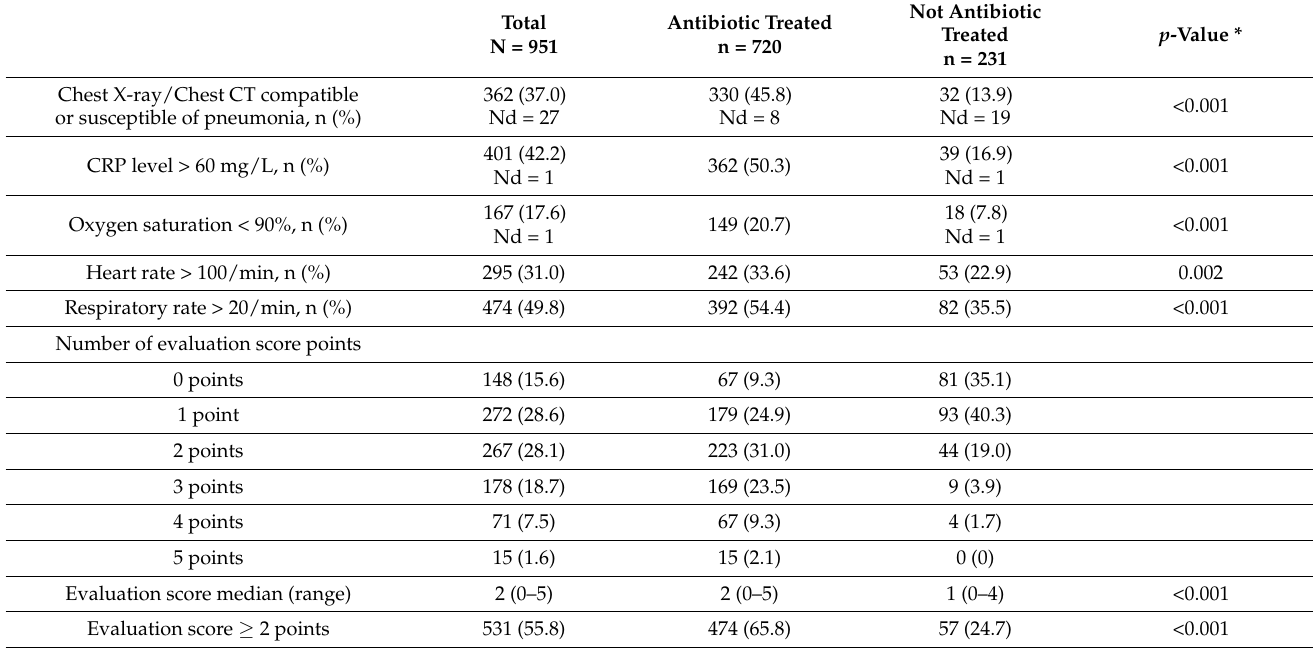
Table 3. Five factors potentially influencing initiation of antibiotic treatment (evaluation score 0–5 points) in 951 infection